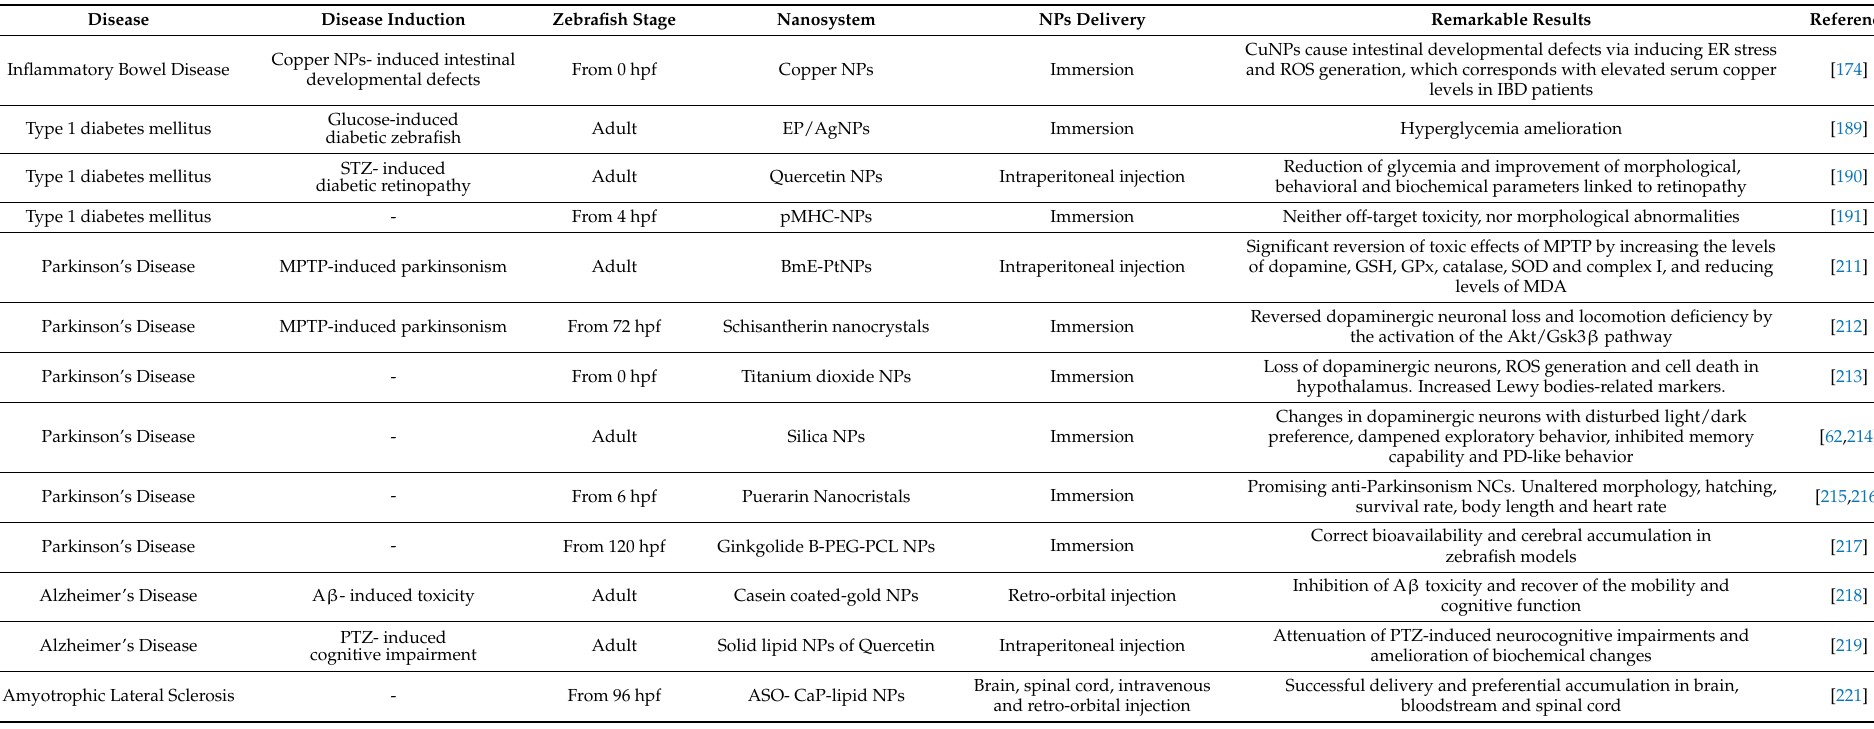
Table 2. Summary of nanoparticles tested in zebrafish models of autoimmune diseases: inflammatory bowel disease, type I diabetes mellitus, parkinson’s disease, alzheimer’s disease, amyotrophic lateral